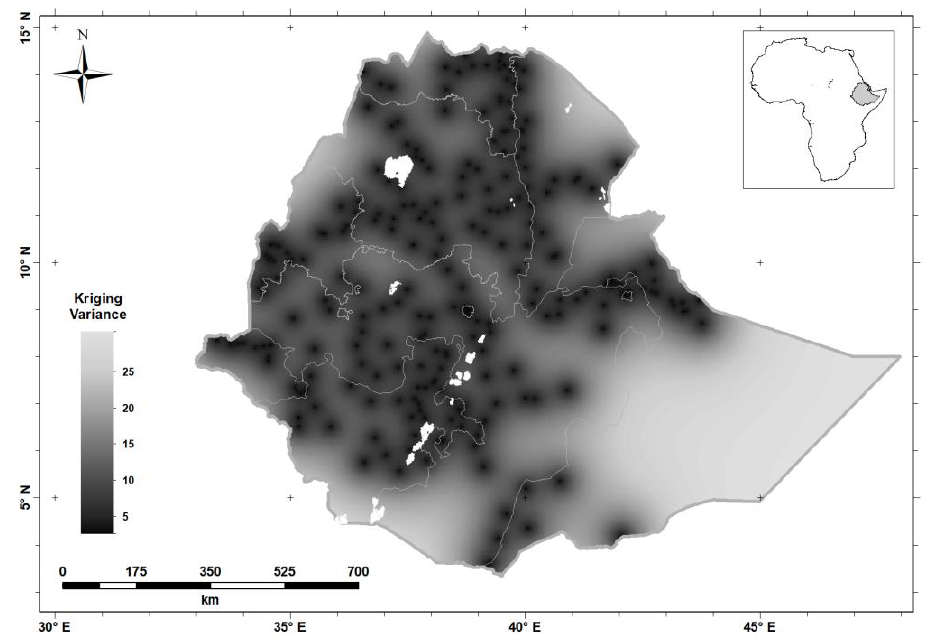
Figure 6. Serum Se concentration kriging variance (the variance of the prediction distribution) in women of reproductive age in Ethiopia.